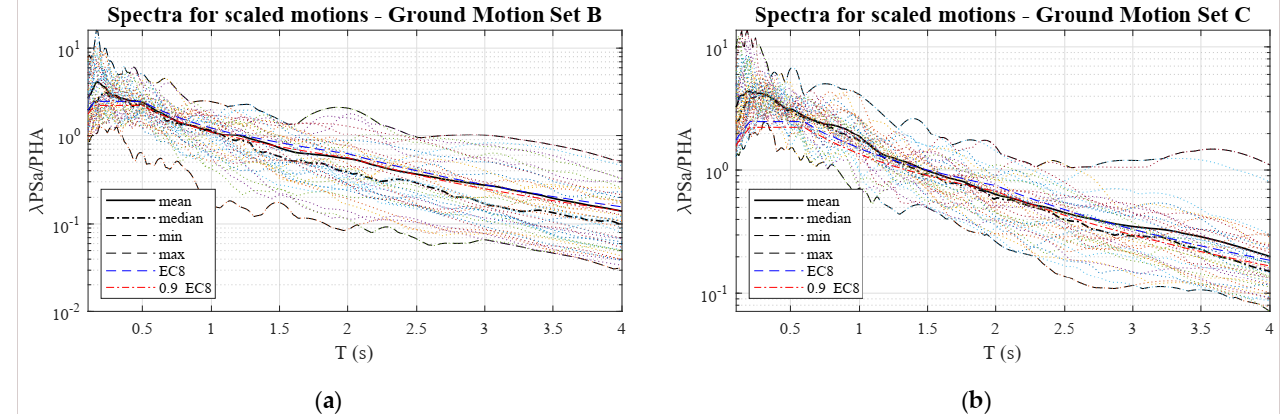
Figure A2. Pre-scaled and normalized Sa spectra for Ground Motion Selection and comparison with Eurocode 8 5% elastic response spectrum; ( a ) GMS B; ( b ) GMS